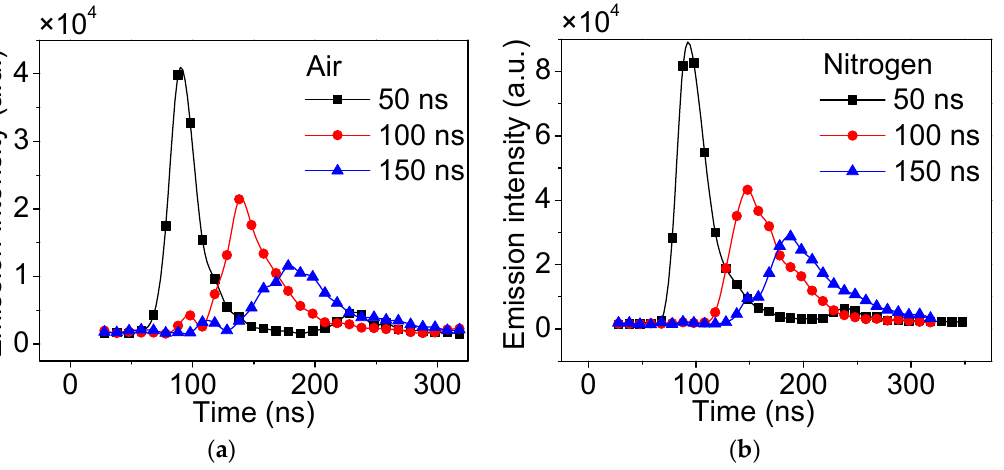
Figure 15. Time evolution of the emission intensity of SPS of N 2 under different pulse rising and falling times in ( a ) air and ( b ) pure nitrogen.